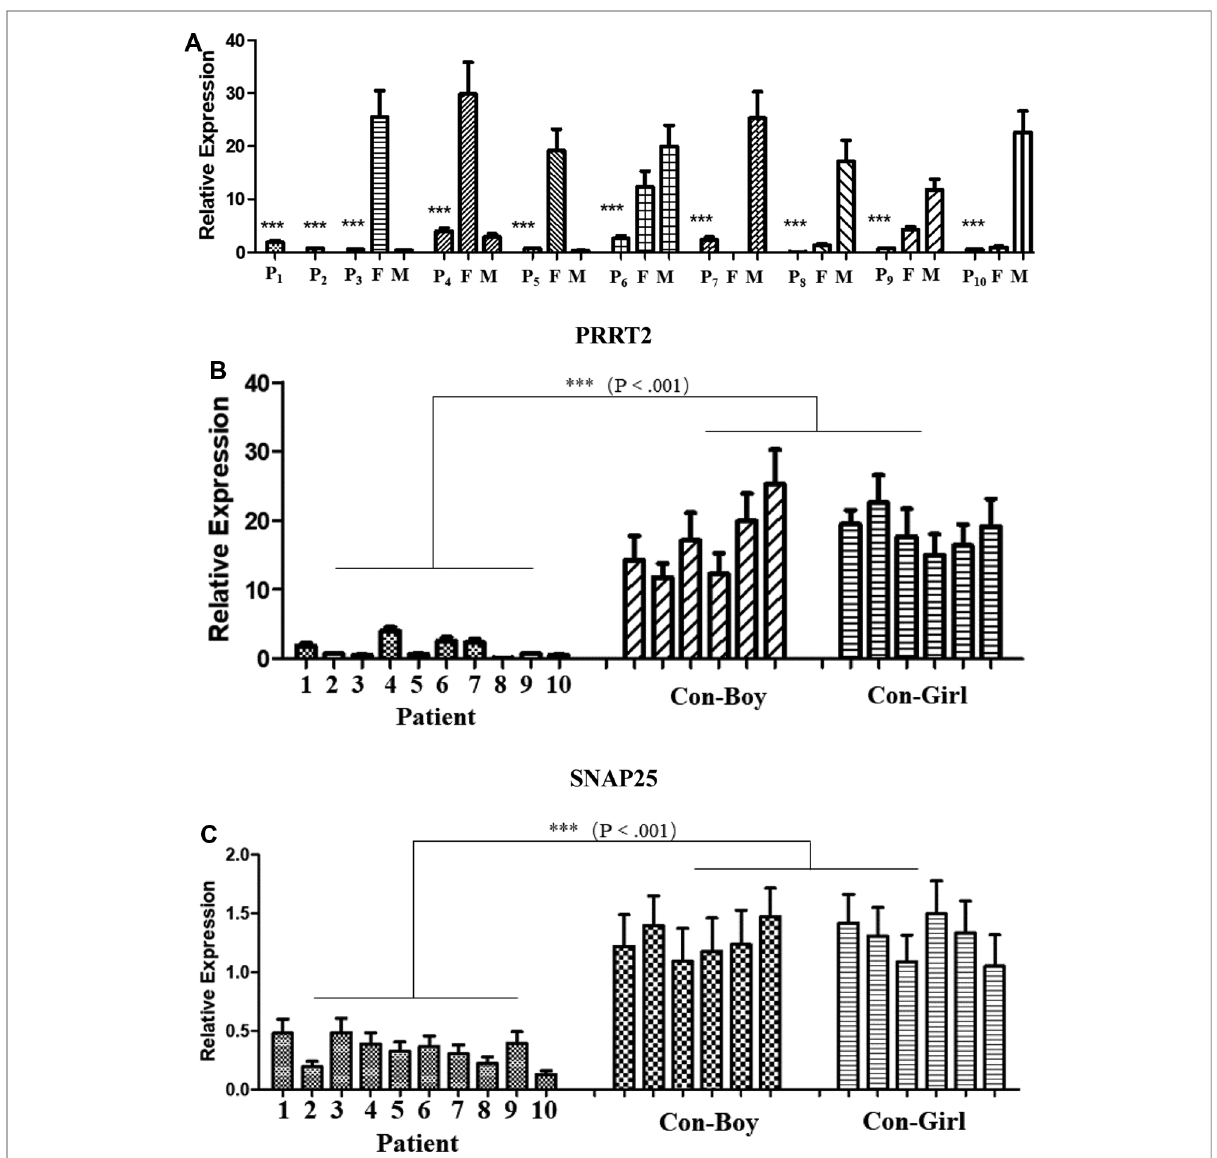
FIGURE 1 Quantitative polymerase chain reaction (qPCR) analysis of proline-rich transmembrane protein 2 ( PRRT2 ) and synaptosome-associated protein 25 ( SNAP25 ) gene expression. P1 – P10, patients 1 – 10; F, father; M, mother; CON-Boy, control boys; CON-Girl, control girls. (*** P ≤ 0.001). PRRT2 expression level in ( A ) patients and their parents and ( B ) patients and control children of the same age. ( C ) SNAP25 expression level in patients and control children of the same